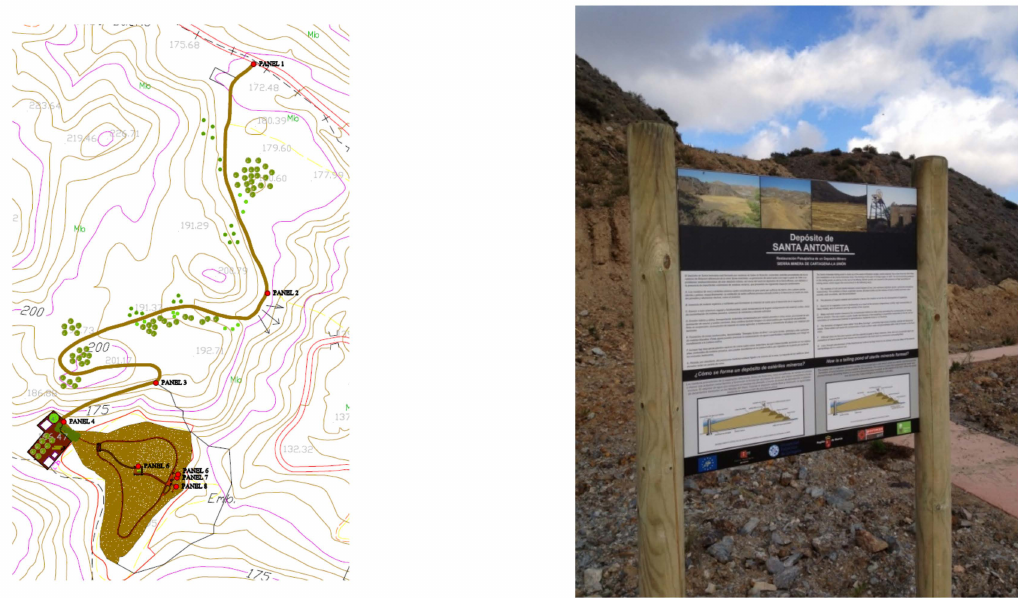
Figure A12. Definition of location of panels of the itinerary and example of panel in Case Study 1.